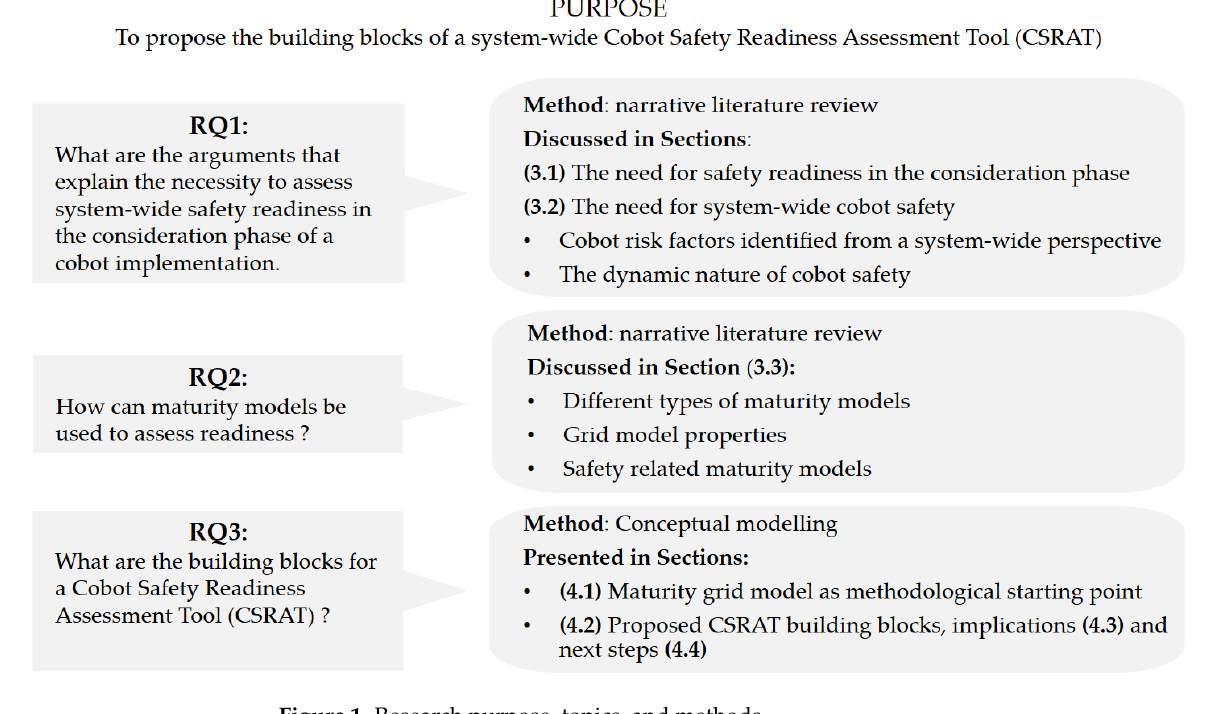
Figure 1. Research purpose, topics, and methods.